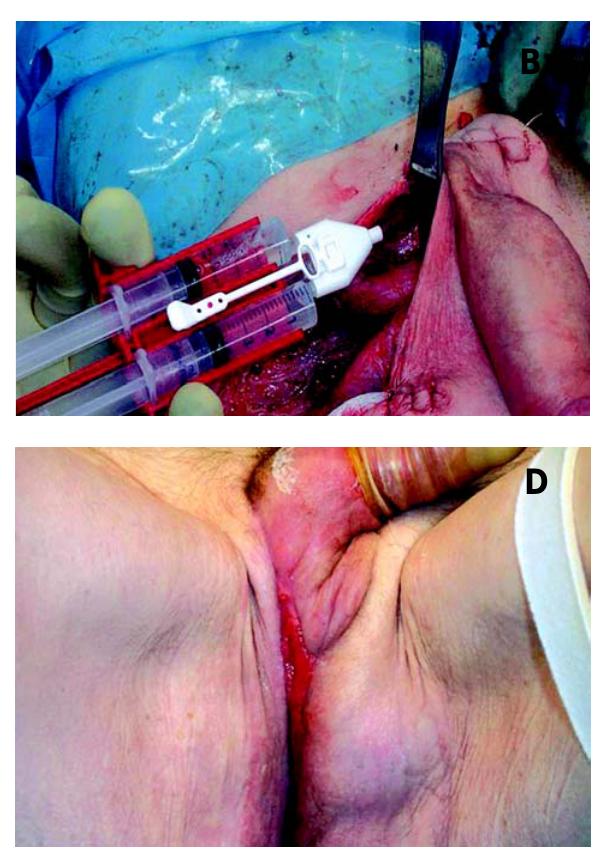
Figure 5 – Successful Fournier’s gangrene reconstruction as- sisted by fibrin sealant. A) Genital wound after initial debride- ment for extensive perirectal necrotizing infection with extensive scrotal involvement. B) Lateral view of same patient after sec- ond debridement showing application of aerosolized fibrin seal- ant sprayed under local tissue flaps to enhance adherence, he- mostasis, and promote wound healing. C) Final appearance im- mediately after secondary debridement shows surrounding skin flaps mobilized to shrink the tissue defect, glued into place with fibrin sealant. Catheter is in presacral cavity in area where ne- crotic rectum had previously been. D) Final appearance after wound vac assisted closure 2 months postoperatively. No grafts or additional skin flaps were used to provide skin coverage. Tes- tes are still buried in thigh